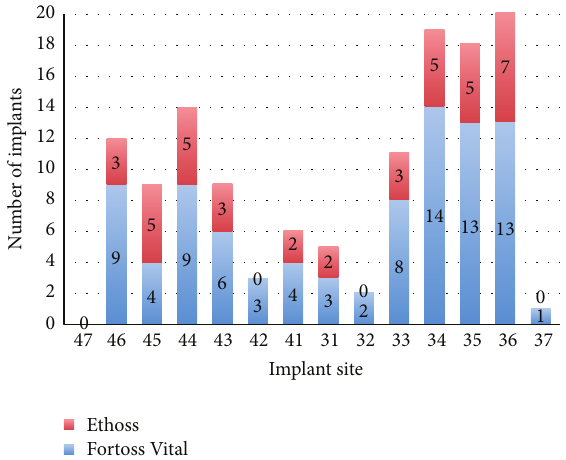
Figure 2: Implant distribution and grafting material used in